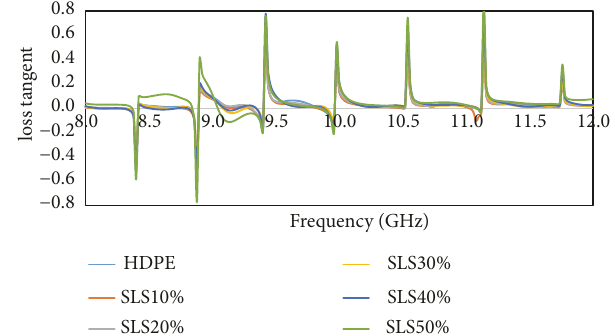
Figure 6: Variation in loss tangent of SLS-HDPE